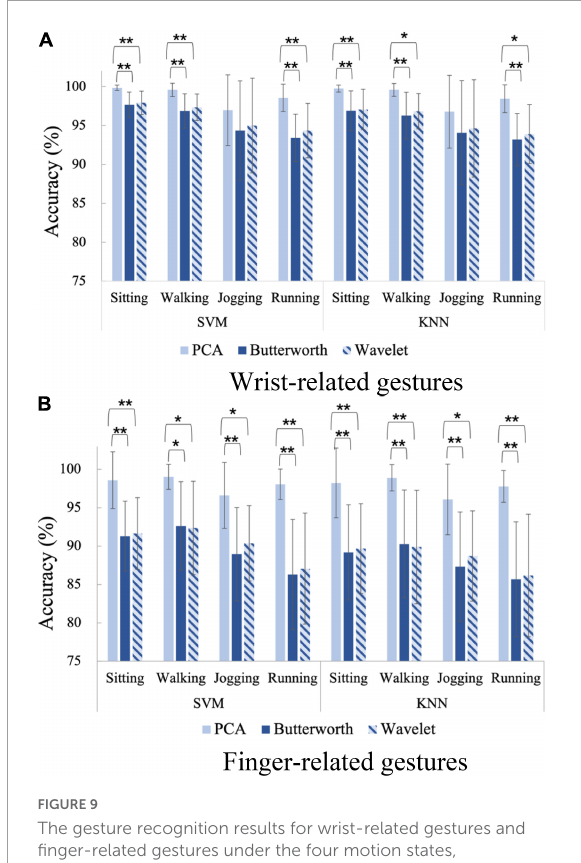
FIGURE9 The gesture recognition results for wrist-related gestures and finger-related gestures under the four motion states, ∗ p < 0 . 05, ∗∗ p < 0 . 001. (A) Wrist-related gestures. (B) Finger-related